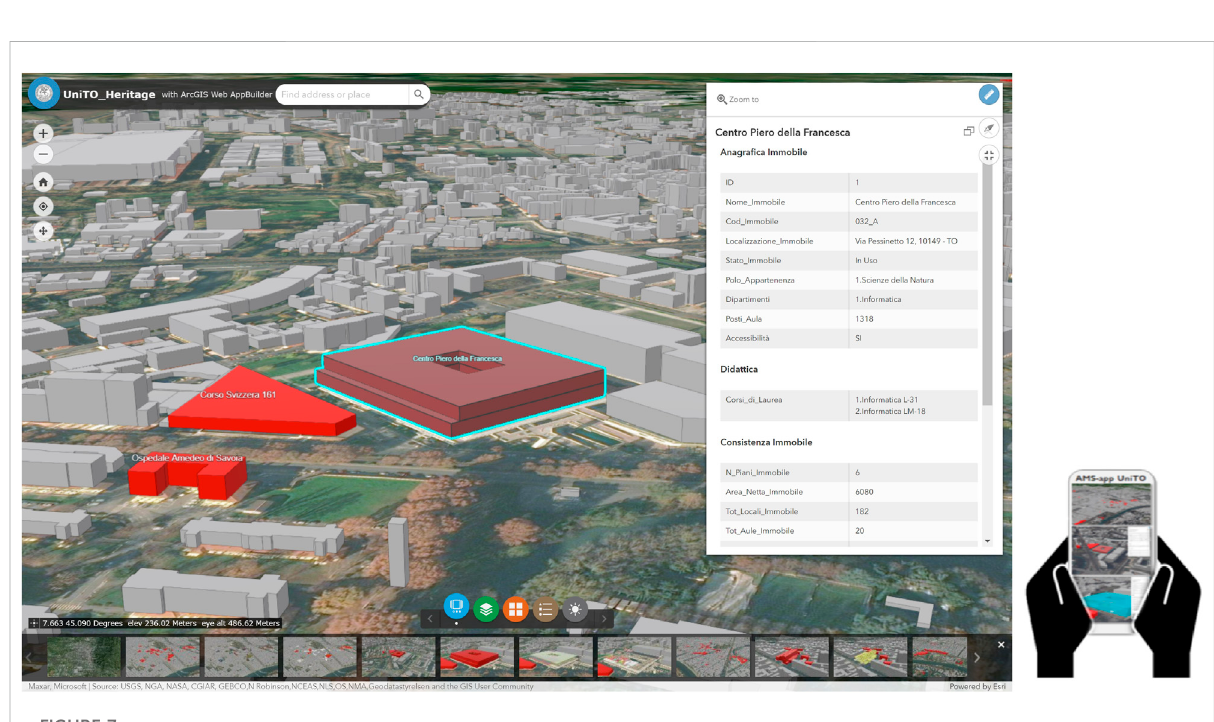
FIGURE 7 AMS app with example of building